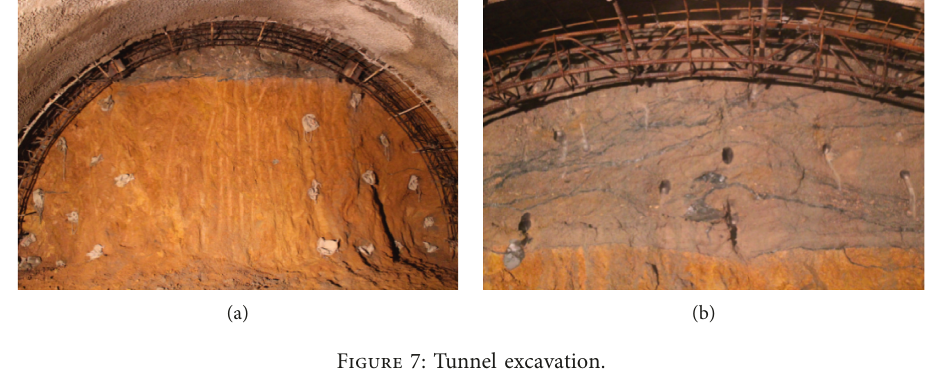
Figure 7: Tunnel